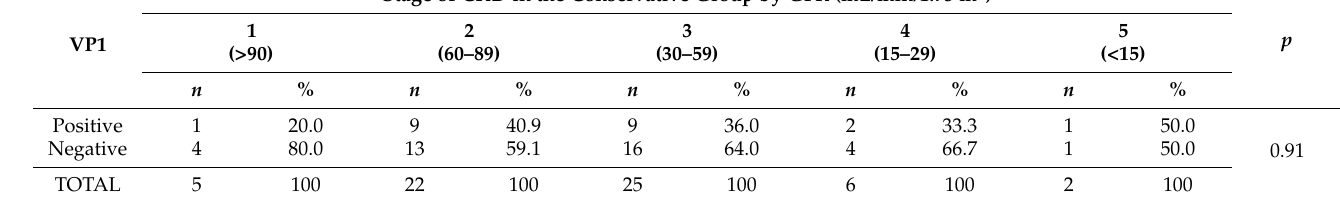
Table 3. Prevalence of polyomavirus in the group with CKD as a function of glomerular filtration rate in Bel é m, Par á , Brazil, 2016.